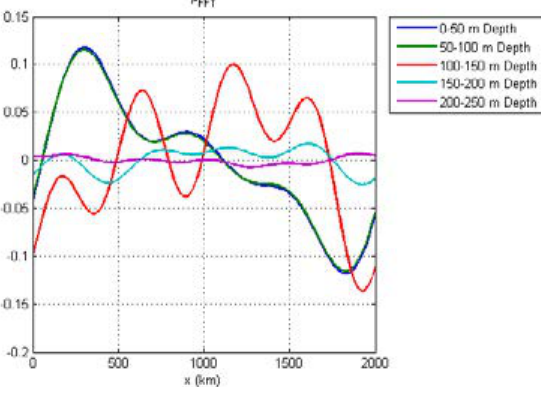
Fig. 9 : The density value of the FFT results at y = 0